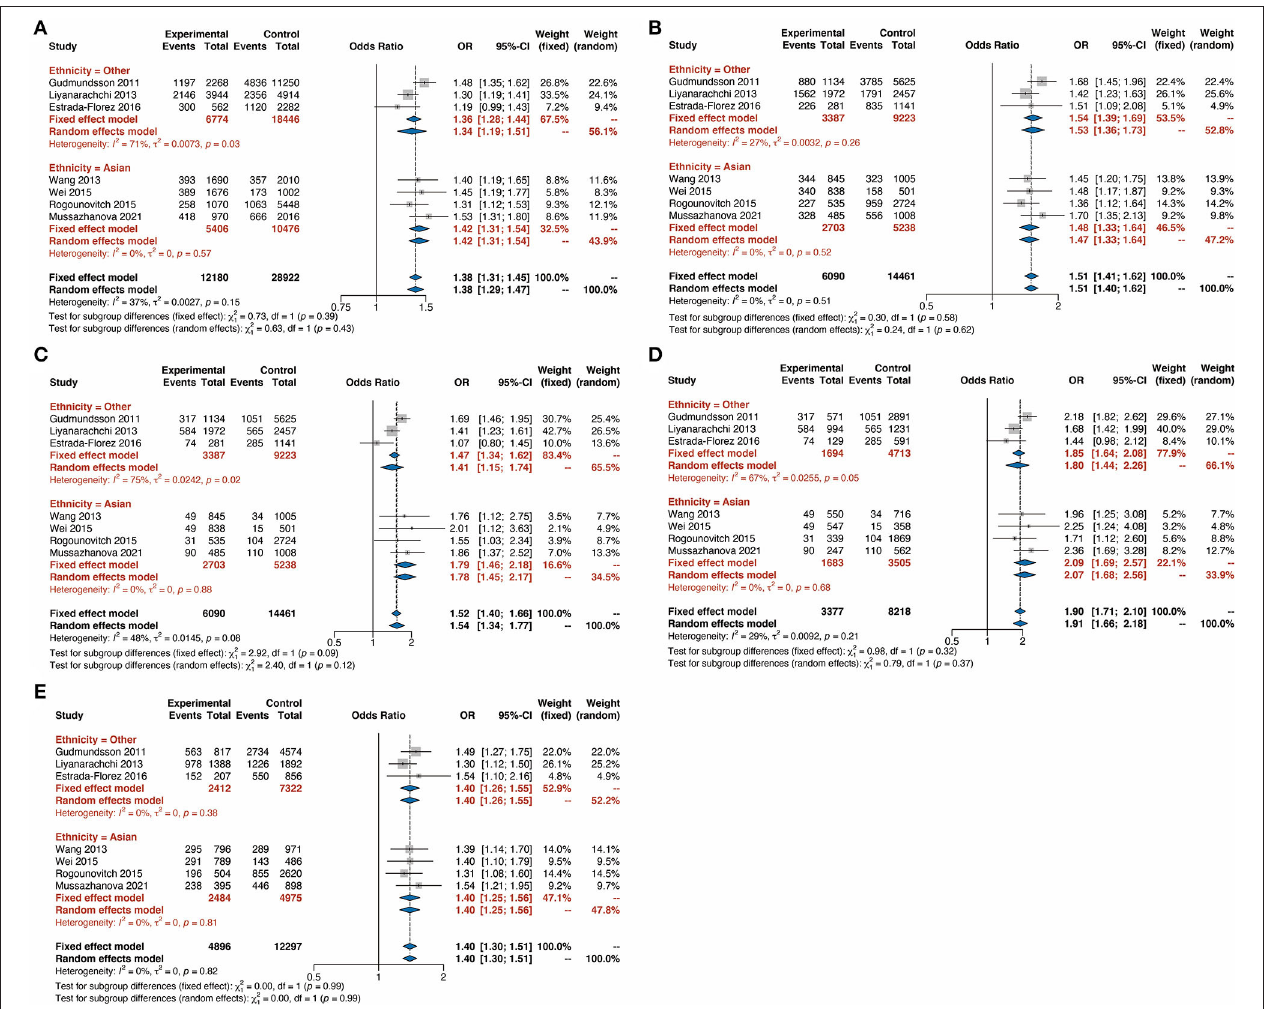
FIGURE 3 | Forest plots for the subgroup-analysis of rs9929218 polymorphism and the risk of thyroid cancer based on ethnicity. (A) G vs. C (allele model). (B) GG plus CG vs. CC (dominant model). (C) GG vs. CC plus CG (recessive model). (D) GG vs. CC (homozygous model). (E) GC vs. CC (heterozygous model). OR, odds ratios; CI, confidence